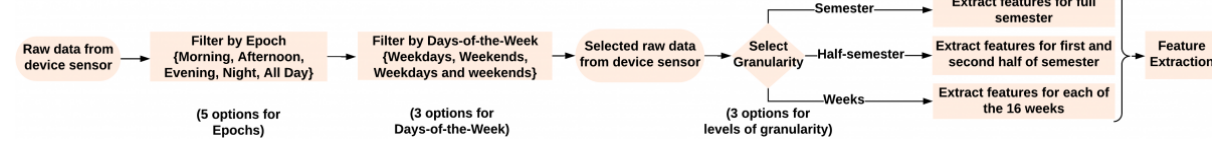
Figure 2. Raw data from each sensor was preprocessed and then filtered by an epoch and a days-of-the-week